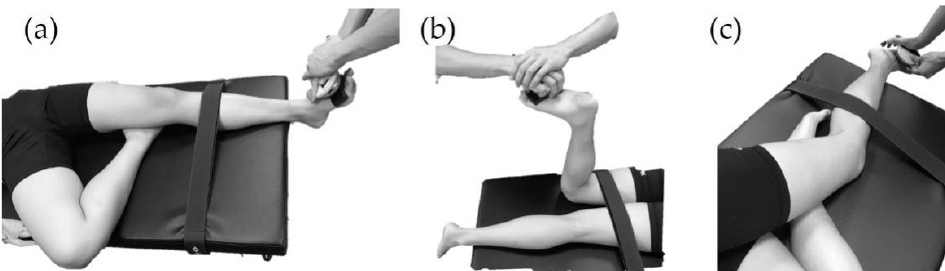
Figure 2. Body position during maximum voluntary isometric contraction (MVIC) test. ( a ) MVIC testing of the tibialis anterior. ( b ) MVIC testing of the gastrocnemius. ( c ) MVIC testing of the peroneus longus.